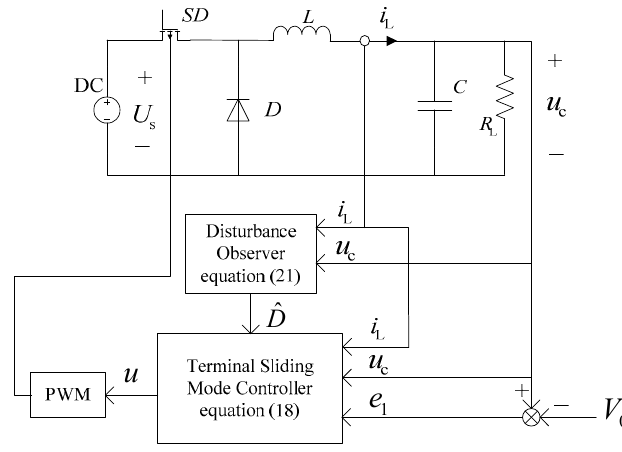
Figure 2. Block diagram of the compound controller for the Buck converter.